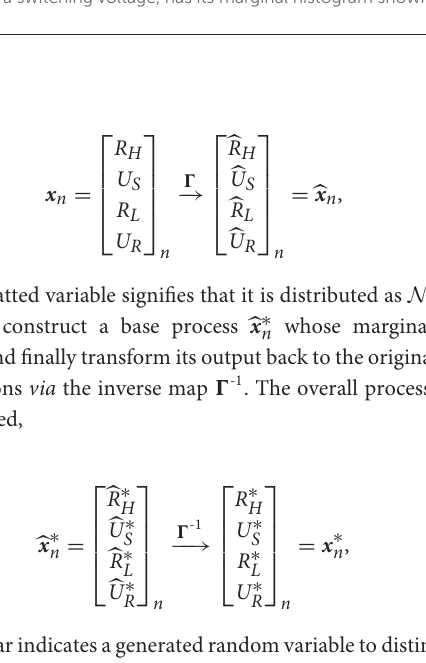
FIGURE6 A view of the feature vector time series extracted from each of 10 6 measured ( I , U ) cycles. Each feature, which represents either a resistance state or a switching voltage, has its marginal histogram shown on the